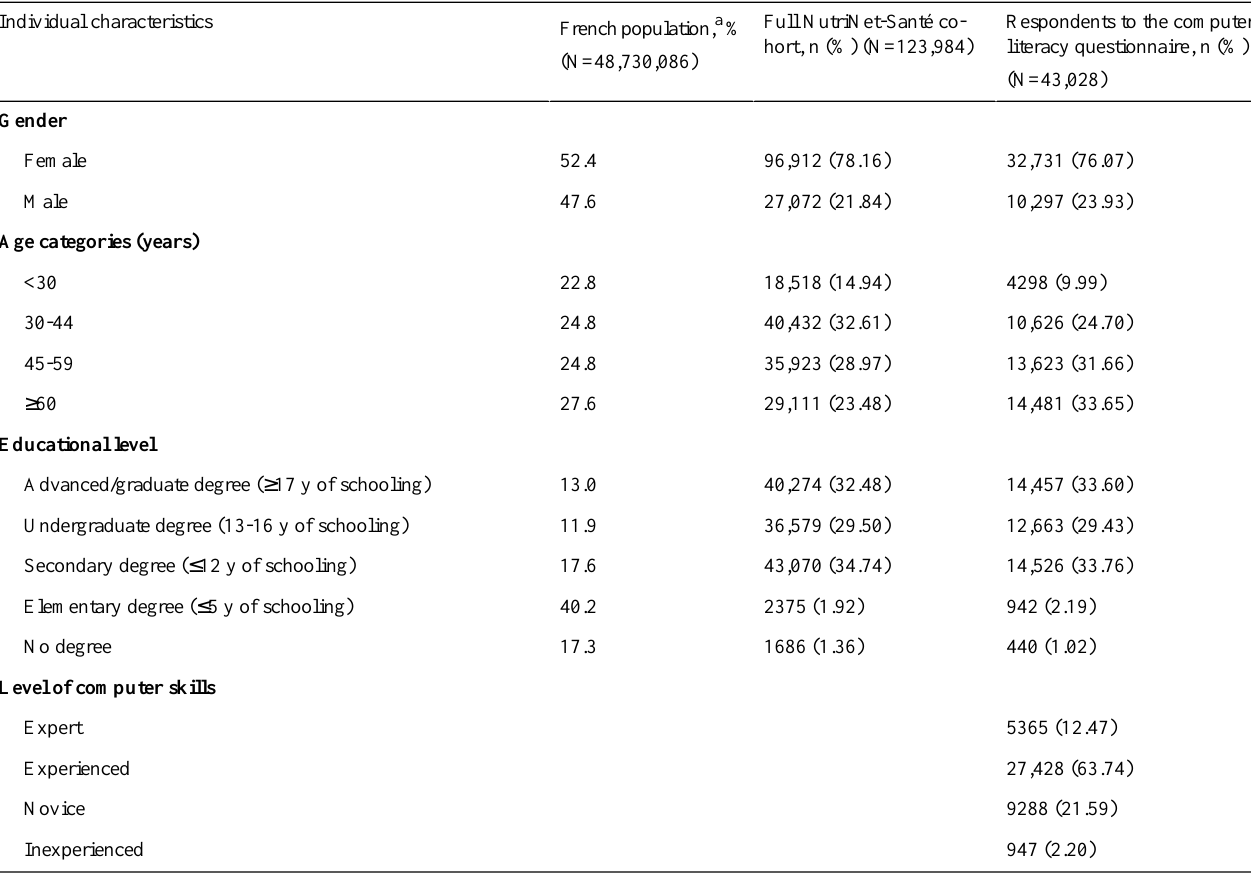
Table 1. Baseline characteristics of respondents to the computer literacy questionnaire, NutriNet-Santé cohort, France,